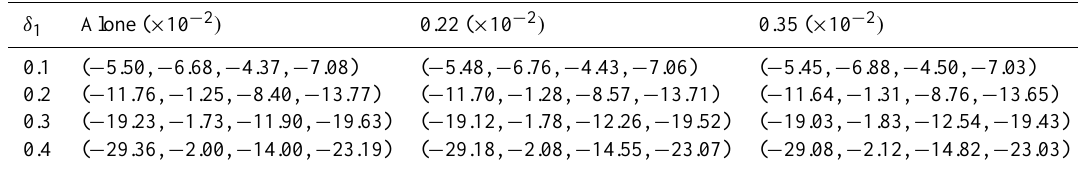
Table 1. The CNOP-Is for different constraint conditions δ 1 .